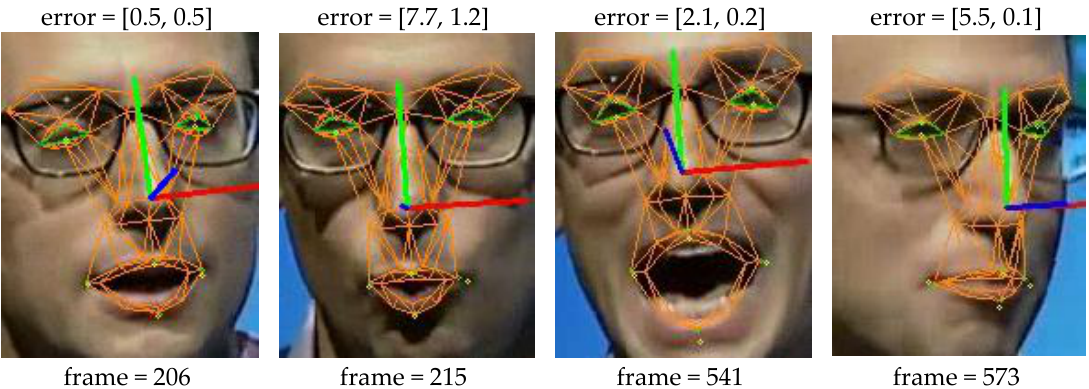
Figure 6. Mouth width and height errors for images from video ”019”. The yellow point is the ground truth, the greed point is the tracked result. The error is defined as absolute difference between the tracked mouth width (height) and the ground truth. Take frame 206 for example, the mouth width error is 0.5 pixels while the mouth height error is 0.5 pixels. The pupil distance is 74.8 pixels for video ”019”.